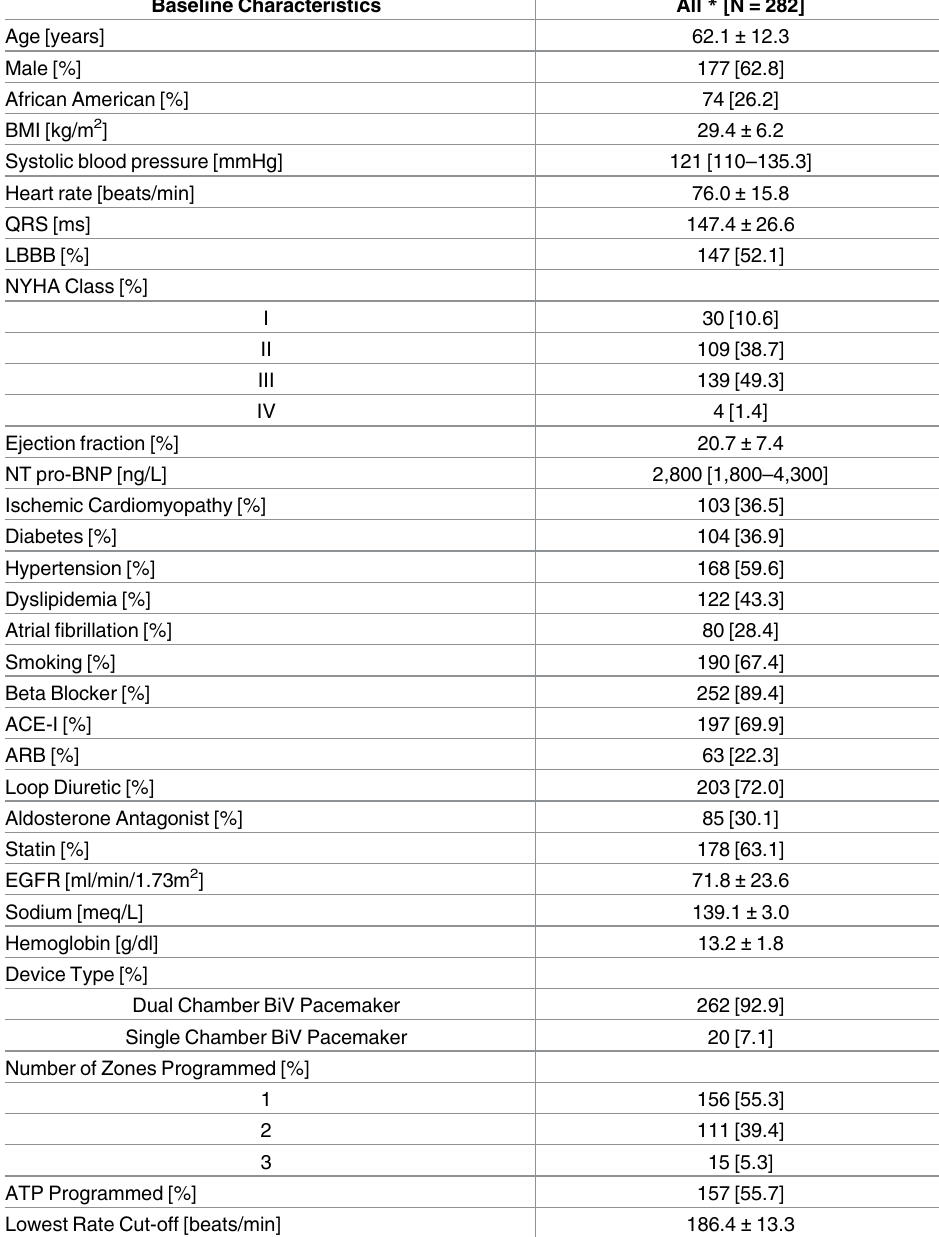
Table 1. Baseline characteristics—All cohort. Baseline